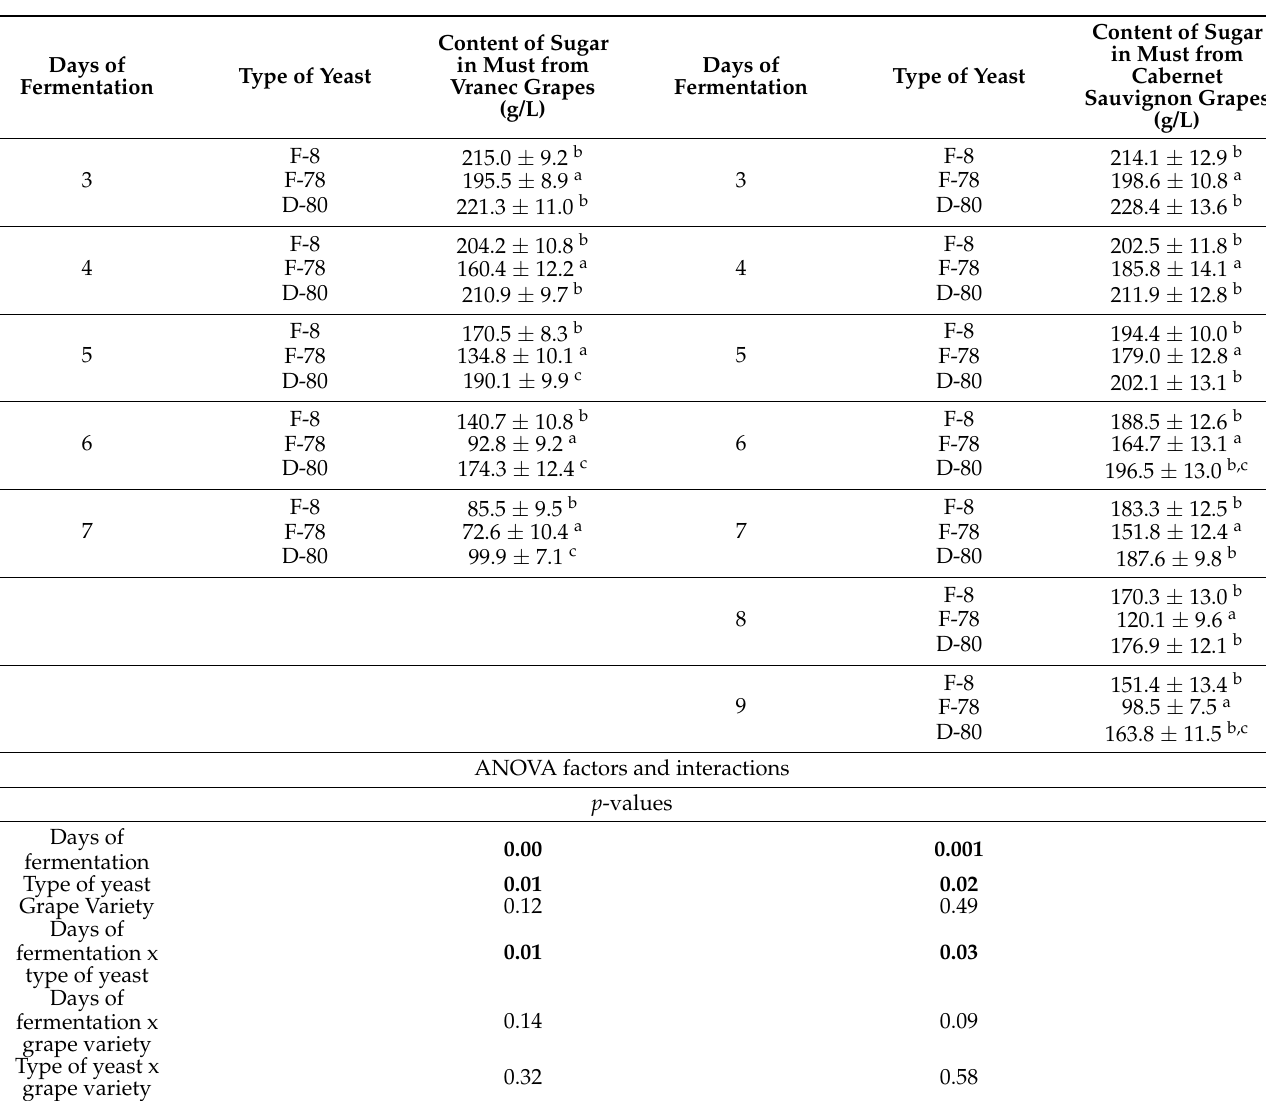
Table 3. Two-way ANOVA statistical analysis for fermentation of the must from Vranec (from the 3rd to 7th days) and Cabernet Sauvignon (from the 3rd to 9th days)